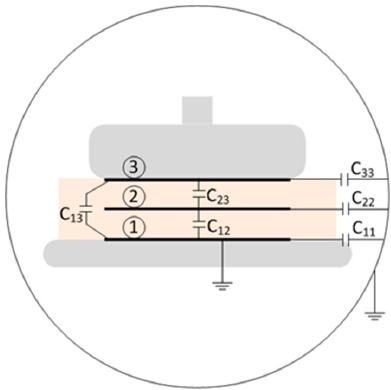
Figure 2. Two layers sample, with the representation of the bottom electrode (1), interface electrode (2), top electrode (3), and their mutual capacitances.